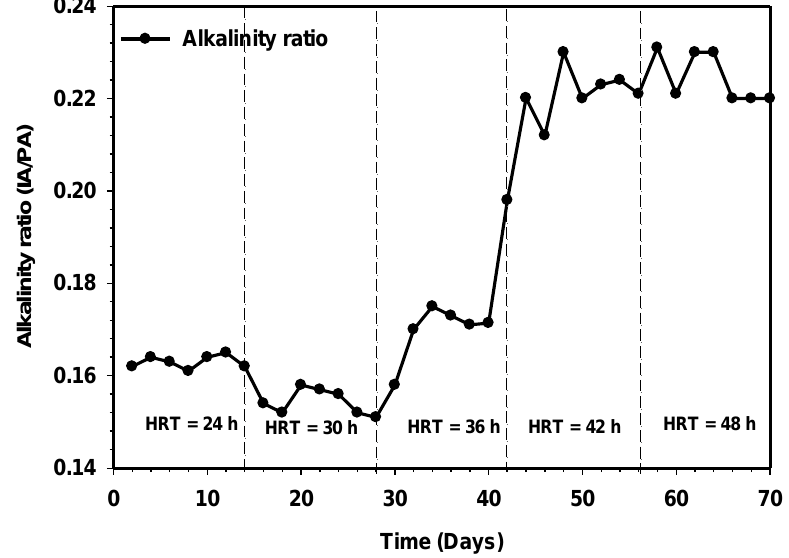
Figure 9. Variation of alkalinity ratio relative to increasing contact time.